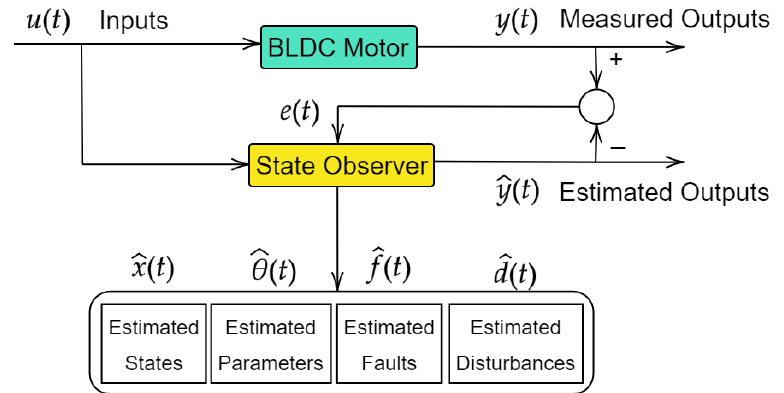
Figure 6. Architecture of a state